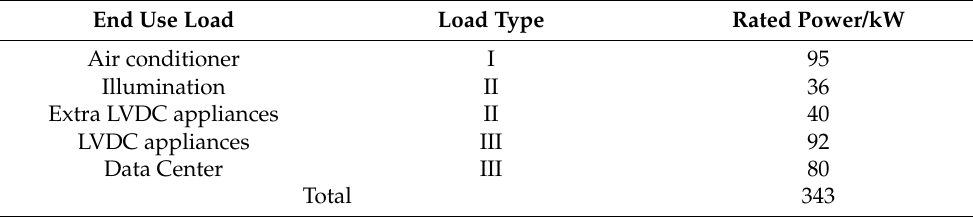
Table 3. Load type and rated